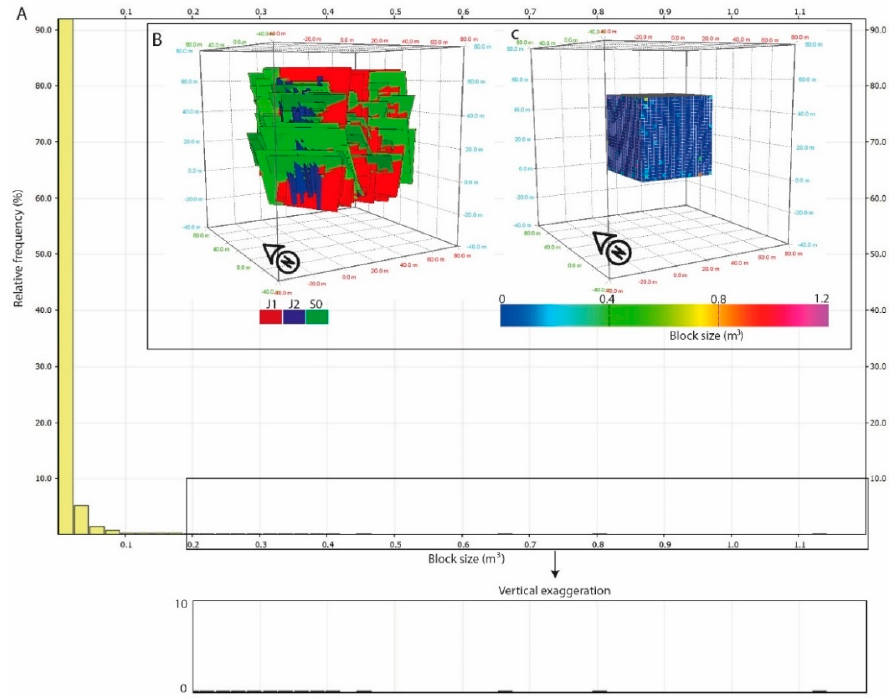
Figure 11. DFN 1. ( A ) Graph of relative block volume frequency (%). ( B ) DFN model of the three discontinuity sets J1, J2 and S0. ( C ) Range of block volumes represented through the discretization of a 40 × 40 m rock mass.